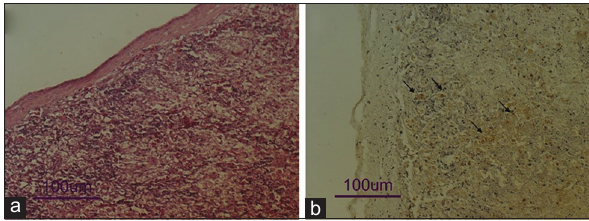
Figure-4: (a) microscopic changes of the spleen with hemorrhage and mark necrosis, especially around white pulp (Hematoxylin-Eosin staining). (b) The Newcastle disease virus-antigen-positive cell surrounding necrotic area; Immunohistochemical staining, with Diaminobenzidine substrate and Mayer’s Hematoxylin counterstain.